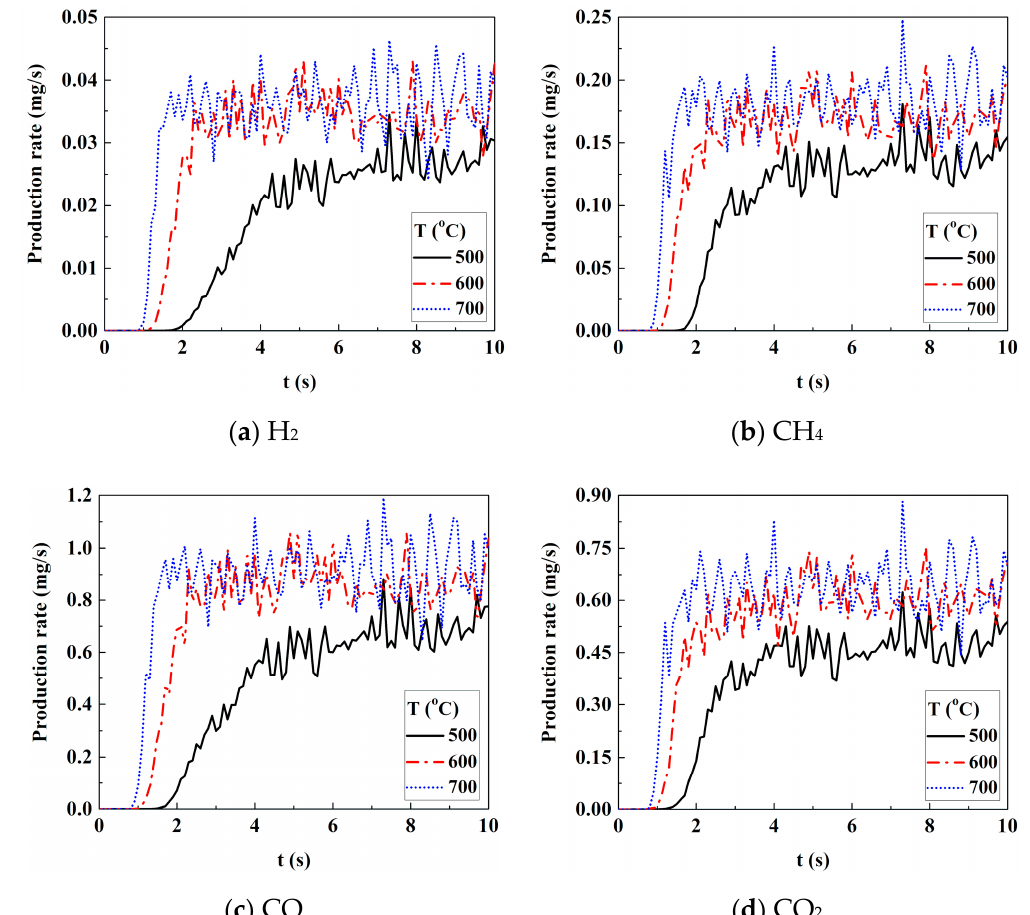
Figure 9. Light gas production rate for different pyrolysis temperatures.